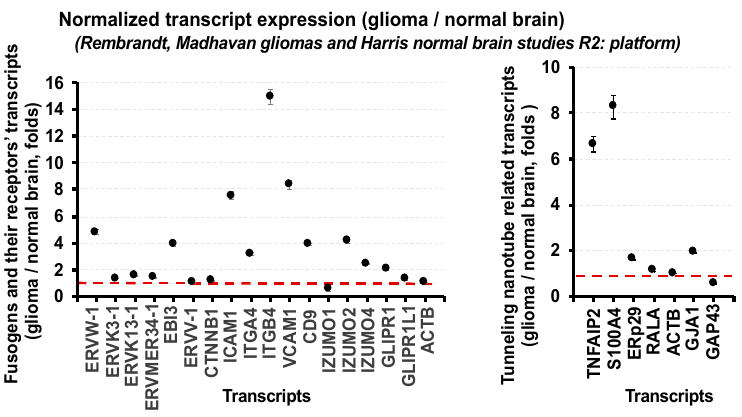
Figure 1. Expression of fusogens and the tunneling membrane nanotube-related transcripts in gliomas compared to normal brain. Graphs illustrate normalized expression of the fusogens and their receptors’ transcripts ( left ) and the tunneling membrane nanotube-related transcripts ( right ) in gliomas compared to normal brain. The following studies from the R2: platform have been utilized for the analysis: Rembrandt, Madhavan, Mas 5.0-U132p2 study for gliomas and Harris, Mas 5.0-U132p2 study for normal brain. Data are shown as mean ± SD. Detailed methods associated with transcriptomic profiling were provided in the R: platform (Rembrandt, Madhavan, gliomas and Harris, normal brain studies).